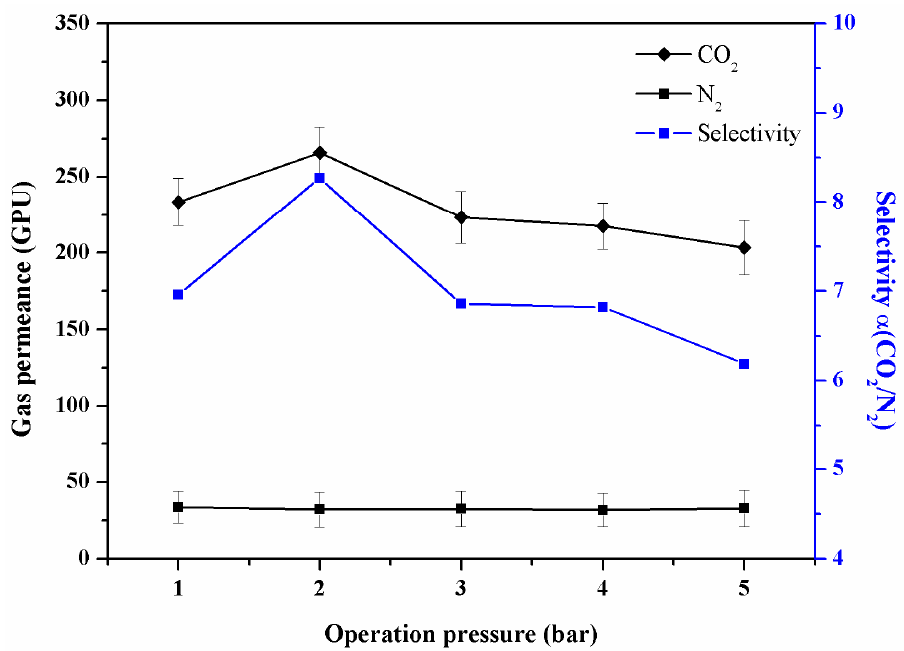
Figure 7. The relationship between gas permeance/selectivity and the operation pressure of the composite membrane CS4.